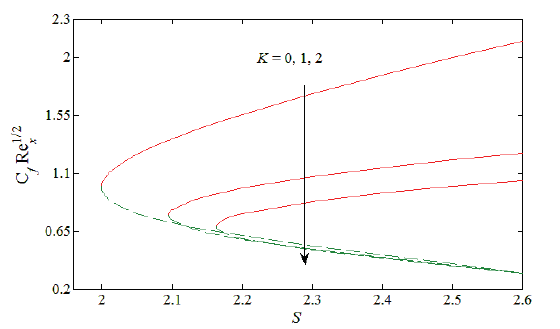
Fig. 12: The skin friction C f Re 1/2 x versus S for different values of K .